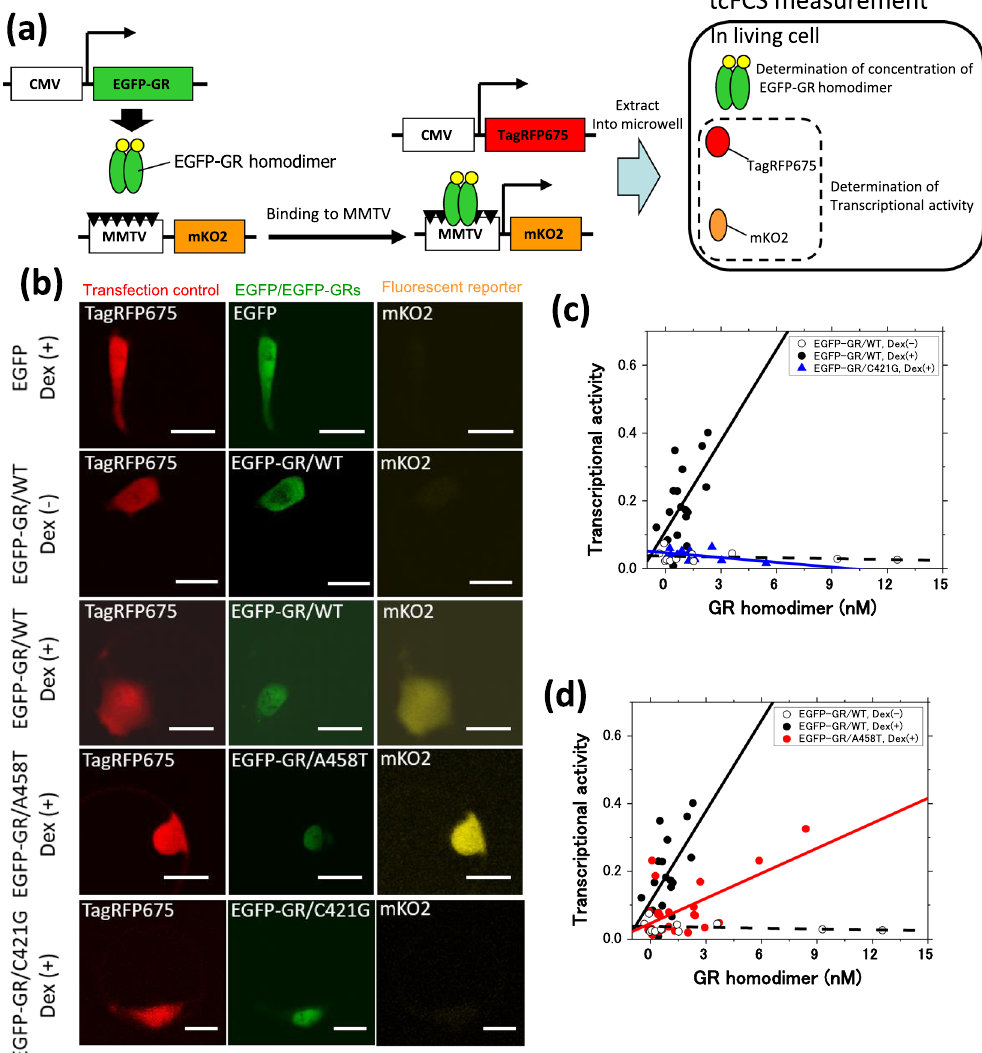
Figure 4. Positive relationship between the concentration of GR homodimer and transcriptional activity, determined using a tcFCS-microwell system. ( a ) A schematic diagram of triple-color FCS (tcFCS) measurement for a transcriptional activity assay. EGFP-GR binding to GREs (black triangle) in the MMTV sequence induces the expression of mKO2. After the extraction of EGFP-GR, mKO2, and TagRFP675 into the microwell, tcFCS measurement was performed. The transcriptional activity was calculated using the concentrations of mKO2 and TagRFP675 (transfection control) from tcFCS measurement. ( b ) Typical fluorescent images of EGFP or EGFP- GRs, mKO2, and TagRFP675 in the absence and presence of Dex. (Scale bar: 20 μ m). (c and d) Transcriptional activity plotted against the concentration of GR homodimer in a single cell. Linear least squares fitting was carried out to determine the slope (Fig. S10) and the Pearson’s correlation coefficient (Fig. S11D). Black open circle: EGFP-GR/WT in the absence of Dex (N = 11), black solid circle: EGFP-GR/WT in the presence of Dex (N = 18), red circle: EGFP-GR/A458T in the presence of Dex (N = 24), blue triangle: EGFP-GR/C421G in the presence of Dex (N = 11), black dashed line: line of best fit of EGFP-GR/WT in the absence of Dex, black solid line: line of best fit of EGFP-GR/WT in the presence of Dex, red solid line: line of best fit of EGFP-GR/A458T in the presence of Dex, blue solid line: line of best fit of EGFP-GR/C421G in the presence of